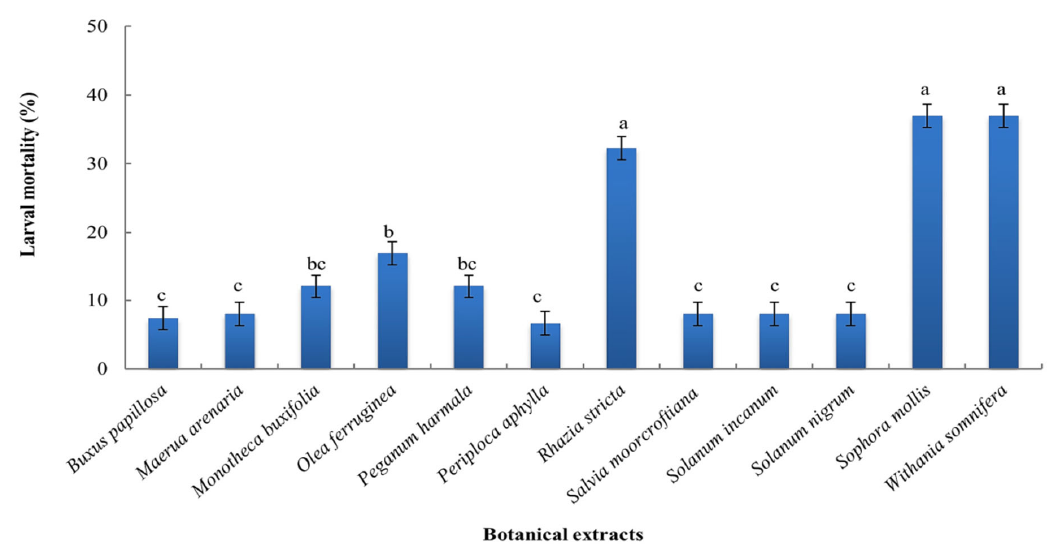
Figure 2. Percent mortality (mean ± SE; n = 10) of 3rd instar larvae of fall armyworm Spodoptera frugiperda at 72 h post ‐ exposure to 20% methanolic extracts of different plant species. Alphabets at bar tops indicate significant differences among the botanical treatments (one ‐ way ANOVA; HSD at α = 0.05). probit analysis revealed that the most effective botanical extract was W. somnifera (LC 50 = 40.42 and 30.21% at 48 and 72 h posttreatment, respectively), followed by S. mollis (LC 50 = 44.09 and 33.32%) and R. stricta (LC 50 = 75.10 and 36.41%) at 48 and 72 h of application,